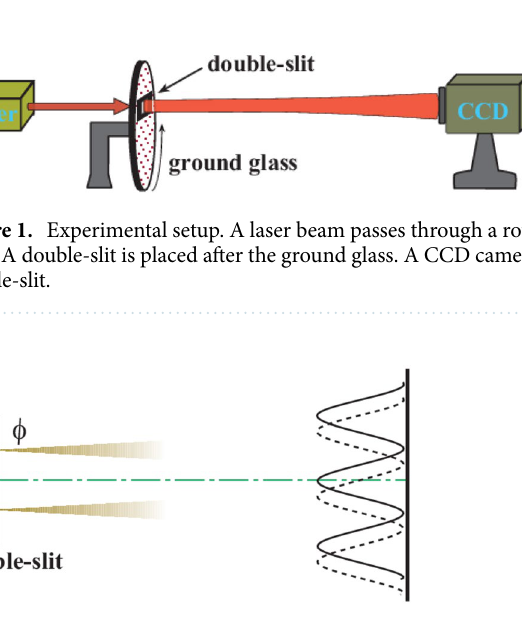
Figure 2. Sketch of the random phase interference model. The intensities from the two slits are assumed equal, and the phase of light from the upper slit is